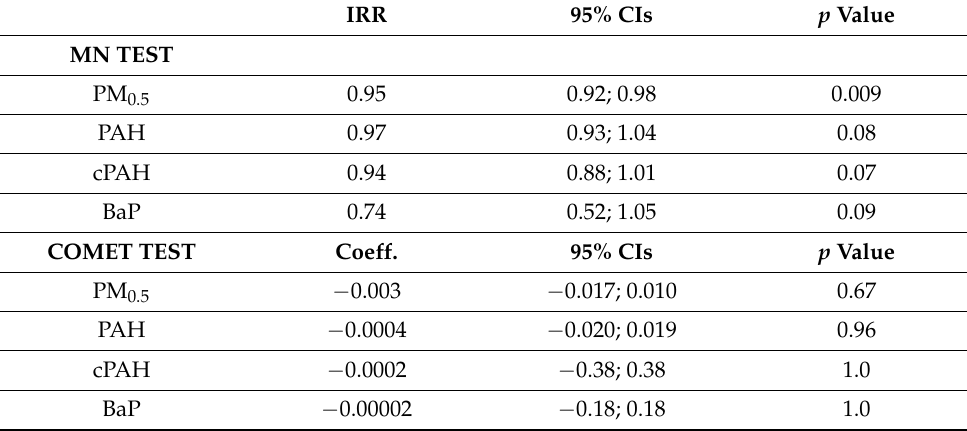
Table 4. Analysis of the associations between MN frequency and DNA damage detected with comet test and concentration of PM 0.5 , PAHs (polycyclic aromatic hydrocarbons), cPAHs (carcinogenic PAHs) and BaP (benzo(a)pyrene) using hierarchical mixed effect Poisson regression models. The incidence rate ratio (IRR), and coefficient of regression (coeff.) and 95% confidence intervals (95% CIs) and p value are